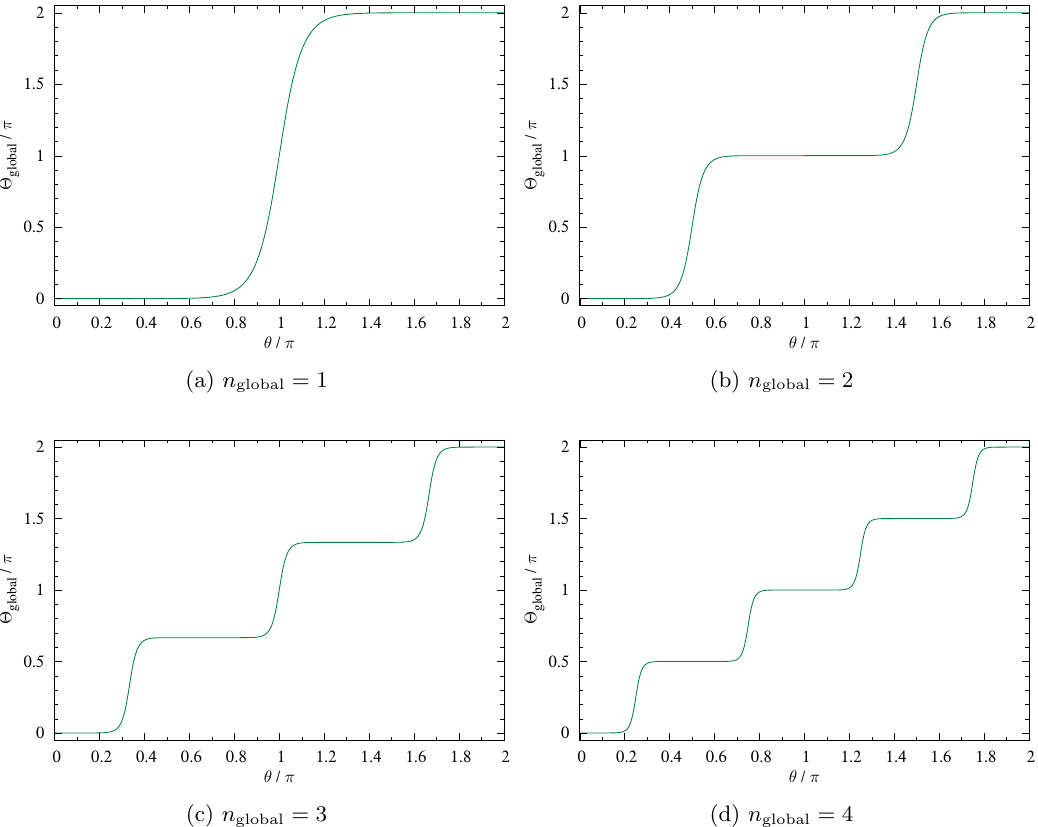
Figure 1 : Angular domain walls for n global = 1 ; 2 ; 3 ; 4. For the (cid:12)gures, the following values where used: r(cid:20) = 5 ; 10 ; 15 ; 20 for the four panels, respectively, and the directional moduli were set to # m = (cid:25) (2 m + 1) =n global , with m = 0 ; 1 ; : : : ; n global , which corresponds to the middle of their respective intervals (maximal